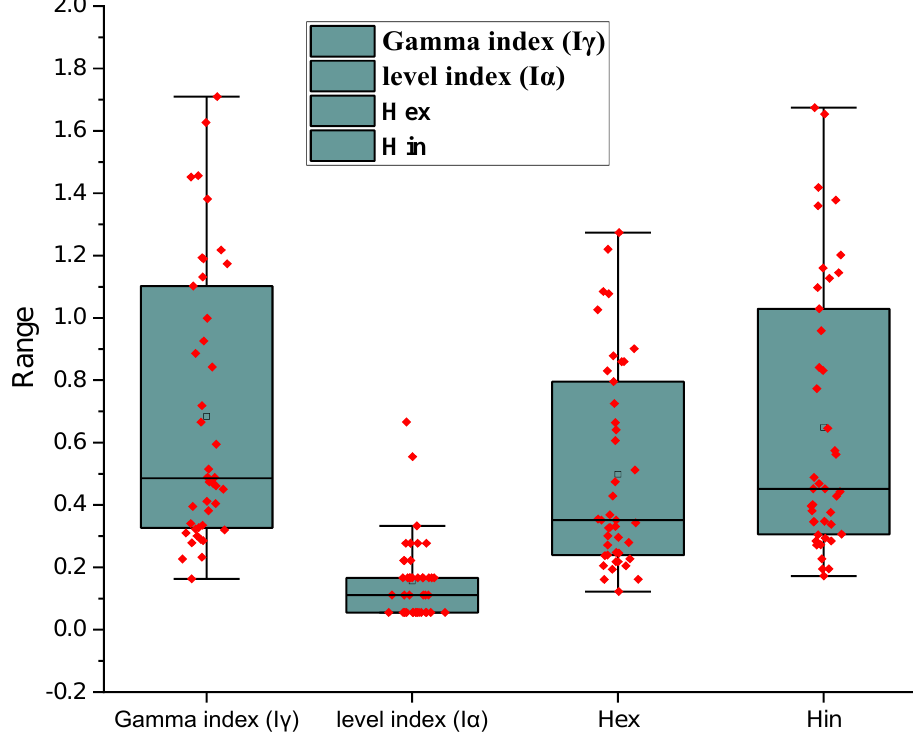
Figure 5. Range, mean, and median line of some radiological hazards in the measured samples. The measured outdoor annual effective dose (AED outdoor ) values for the investigated (cid:16) (cid:17) × samples have been presented in Figure 6 and computed by: AED outdoor = D nGy h − 1 (cid:0) (cid:1) 0.2 × 24 ( h ) × 365 ( d ) × 0.7 × 10 − 6 Sv Gy − 1 [42,43] where 0.2 is the outdoor occupancy (cid:104) (cid:105) Sv factor [34]; 0.7 is the conversion coefficient from the absorbed dose in the air to the Gy effective dose received by adults; and 10 − 6 is the conversion factor between nano- and (cid:104) (cid:105) nGy millimeter measurements. D is the total air absorbed dose rate outdoors, and 8760 h h (cid:104) (cid:105) 24 h × 365 days). The values ranged from 25.66 (HG4) is the number of hours in a year ( day to 265.30 (Sy5) µ Svy − 1 , with an average value of 106.09 µ Svy − 1 . That is HG4 (Biotite Gneisses) and Sy5 (Syenogranites) rocks have the lowest and highest AED outdoor among all (7 hornblende biotite gneisses; 7 biotite gneisses; 14 older granites; and 15 syenogranites) samples, respectively (Figure 6). The AED outdoor values are higher than the corresponding global value of 0.07 mSv. The measured indoor annual effective dose (AED indoor ) values for the examined rock samples have been shown in Figure 7. The values are ranging from 102.60 (HG4) to 1061.19 (Sy5) µ Sv/yr, with an average value of 424.35 µ Sv/yr. HG4 and Sy5 rock samples have the lowest and highest AED indoor values, respectively, among all samples (Figure 7). The AED indoor values are higher than the corresponding global value of 0.410